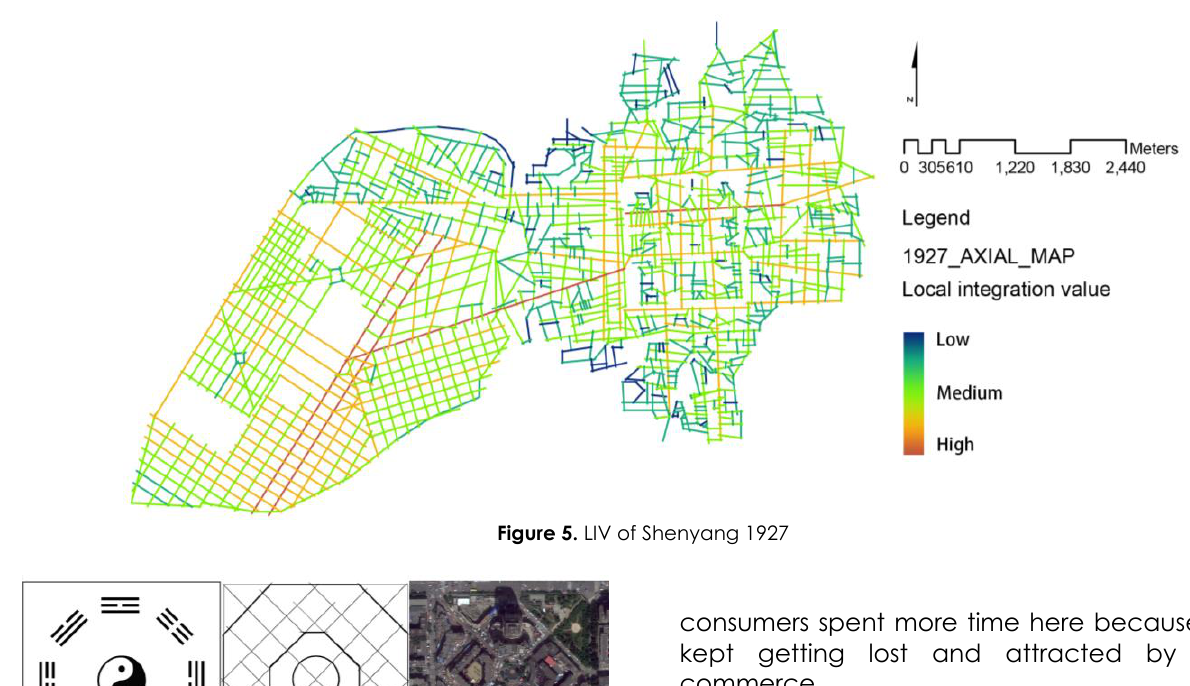
consumers spent more time here because they kept getting lost and attracted by other